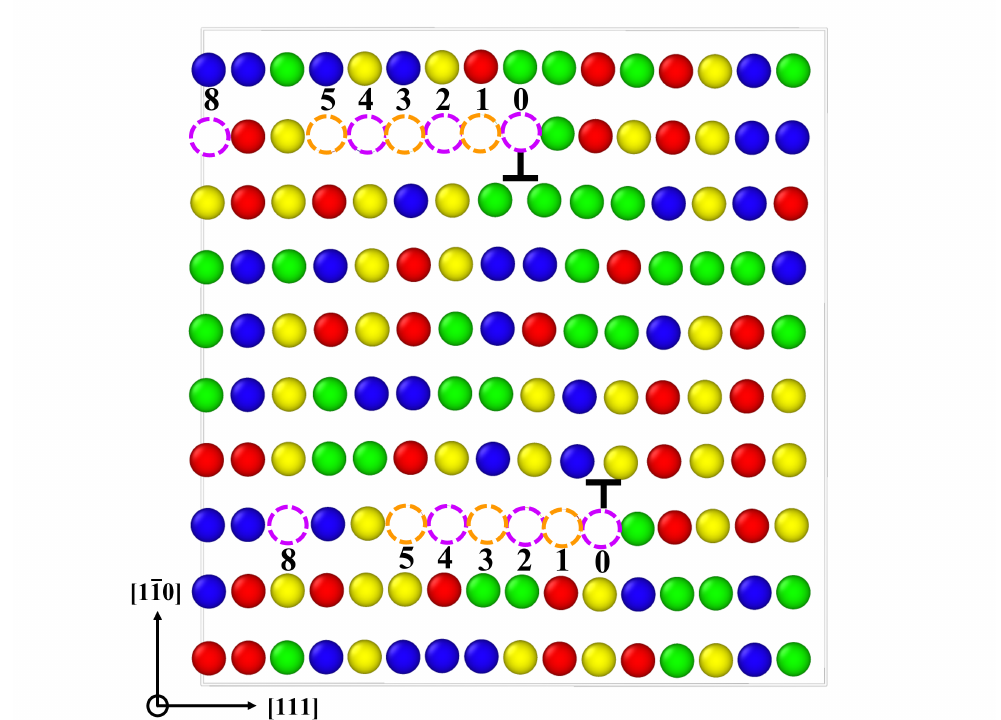
Figure 9. A cell of random Nb-Mo-Ta-W with an edge dislocation dipole. The ‘ ⊥ ’ symbols mark the exact locations of dislocation cores. The dashed circles indicate locations with varying atomic distances from dislocation cores (e.g., position ’0’ is of zero interatomic distance from the core). Colors represent different atomic species: red = Ta, blue = Nb, yellow = Mo, green =